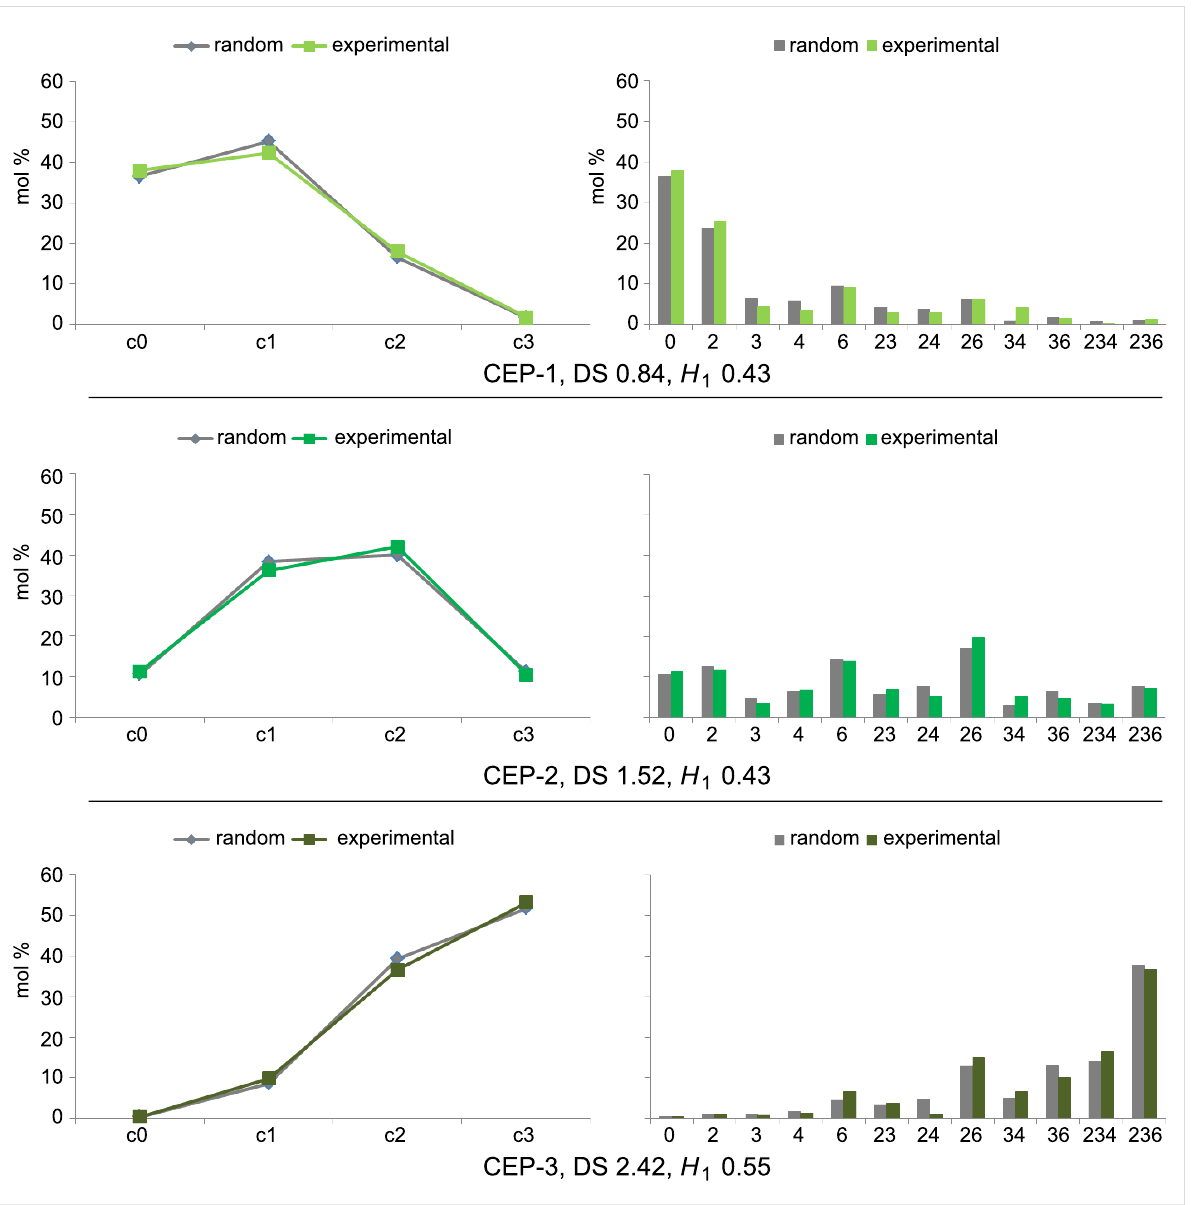
Figure 8: Experimentally determined substituent distribution in the glucosyl units (glc) of cyanoethylpullulans CEP-1–3 (green) compared to a random pattern (gray). Left: c i = the fraction of i-fold-substituted glucosyl units (mol %); right: un = unsubstituted glc; the numbers assign the substituted posi- tions, e.g., 234 = 2,3,4-tri- O -cyanoethyl glc; H 1 heterogeneity parameter for the standard deviation as defined in Table 2.